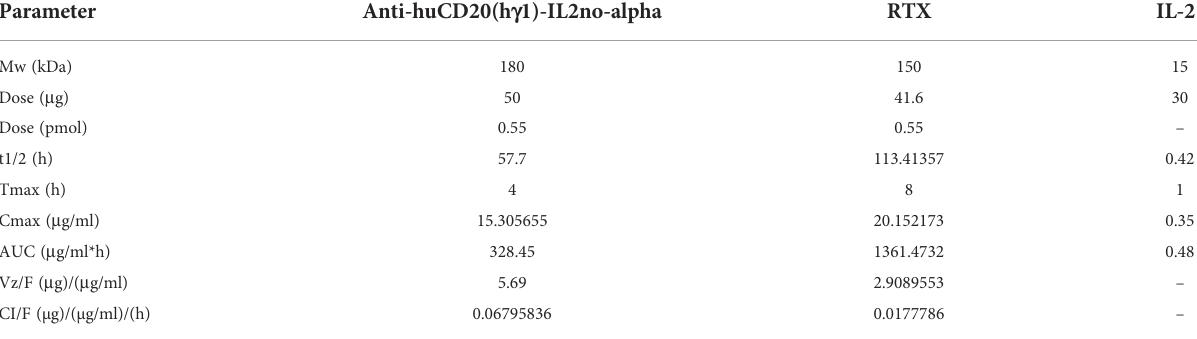
TABLE 1 Summary of the pharmacokinetic parameters of anti-huCD20(h g 1)-IL2no-alpha ICK, RTX and IL-2 in C57Bl/6 mice following a single i.p. administration of a single equimolar dose (0.5 pmol).